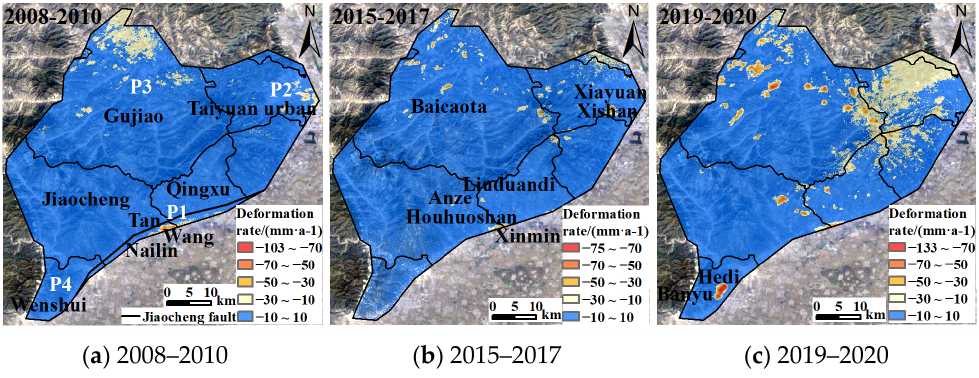
Figure 2. Average annual vertical deformation rate in the Xishan Coalfield. Table 2. Comparison of subsidence rates between different periods in Xishan Coalfield (mm/year). Subsidence Area